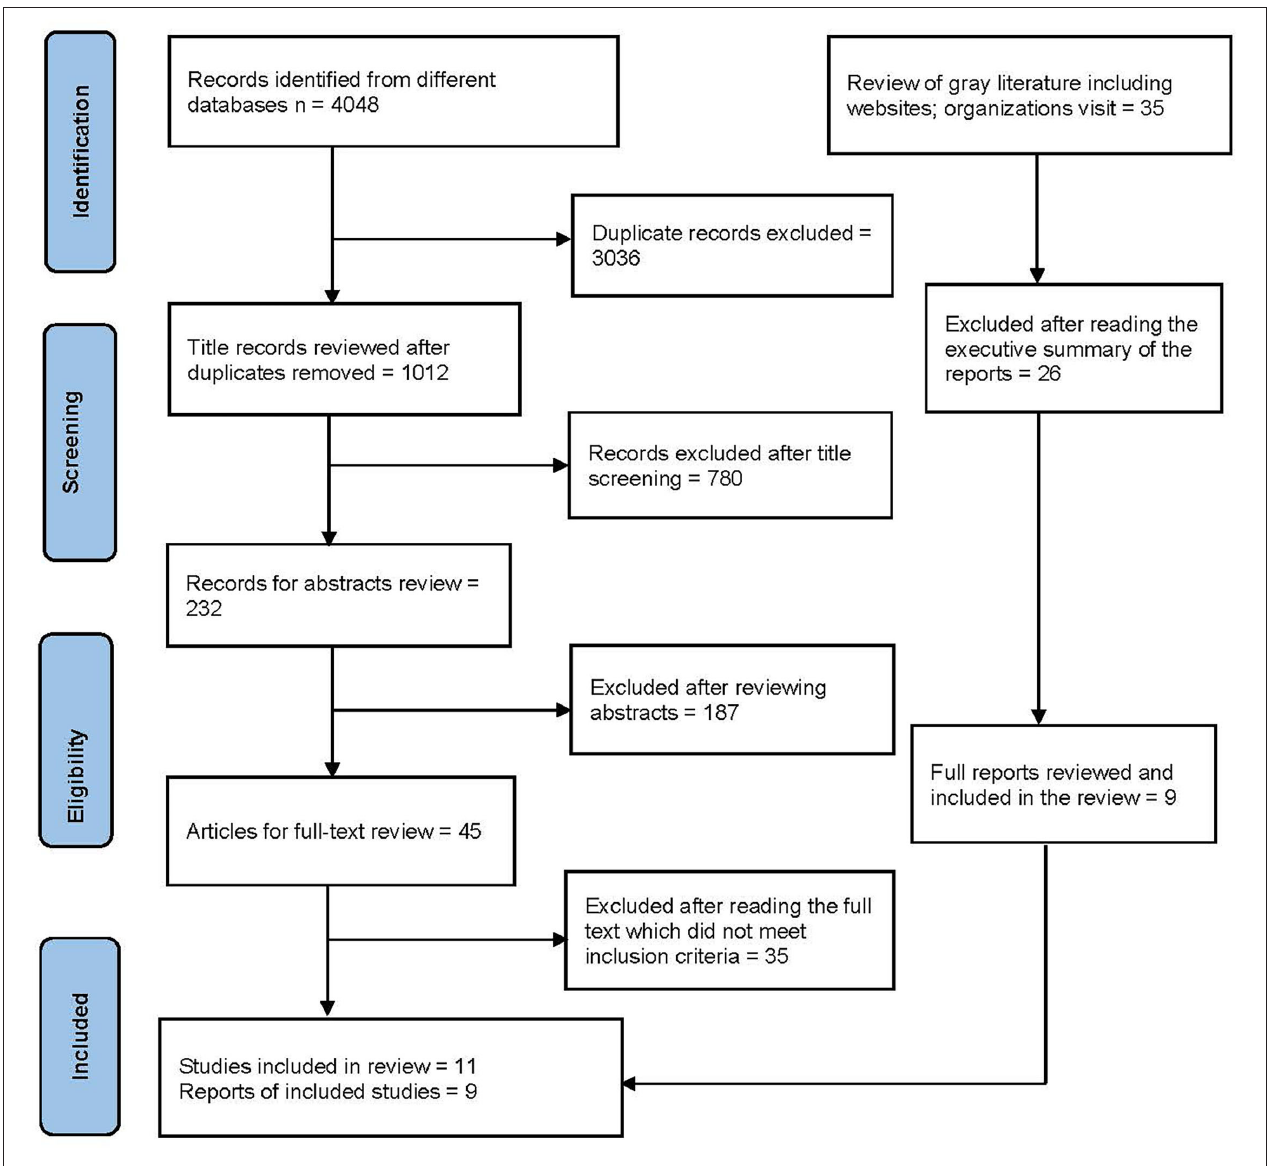
FIGURE 1 | Systematic search and review flow diagram using